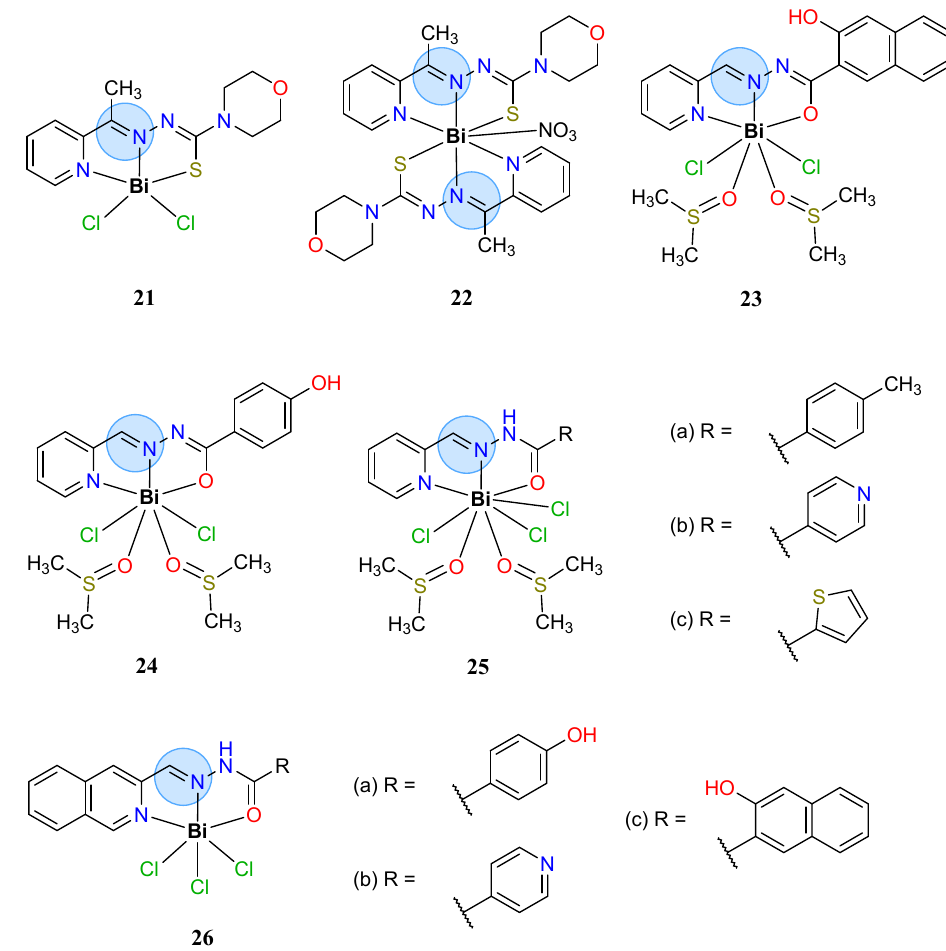
Figure 12. Bi(III) complexes with NNO and NNS asymmetric ligands studied in antimicrobial activity. On the other hand, the antimicrobial activity of indium(III) complexes with thiosemicarbazone ligands has also been reported (Figure 13) [105,106]. The [In(III)(L)Cl 2 (MeOH)] complexes 27 have as ligands thiosemicarbazones obtained from 2-acetylpyririne and have been reported to be effective against several strains of Candida , i.e., C. albicans , C. parapsilosis , C. lusitaniae, and C. dubliniensis [106], with better results than free ligands in all cases, highlighting the activity of complex 27b with an IC 50 value of 3.0 ± 1 µ M against C. parapsilosis , which was more effective than the reference drug nystatin (IC 50 = 5.1 ± 0.4 µ M). In the case of C. lusitaniae , the complexes had an equal or better activity than the reference drug nystatin (IC 50 = 2.0 ± 0.3 µ M), while for C. dubliniensis, all the complexes had a better activity (except 27b ) than the reference drug nystatin (IC 50 = 2.3 ± 0.3 µ M). The indium(III) complex with 2-acetylpyridine-N(4)-phenylthiosemicarbazone (complex 28a ) and its gallium(III) homologue (complex 28b ) has low to moderate antibacterial activity (MIC > 62.5 µ g/mL) against Gram-positive bacteria ( B. cereus , B. subtilis , S. aureus , and S. lutea ) and Gram-negative bacteria ( E. coli , A. tumefaciens , S. typhimurium , and P. aeruginosa ), but great cytotoxicity against HepG2 cells. However, it should be noted that in all cases, the antibacterial activity was improved in the presence of the metal compared to the MIC values for the free ligand [105]. The gallium complex with tridentate thiosemi ‐ carbazones has also been reported to show antimicrobial activity. Beraldo’s group also